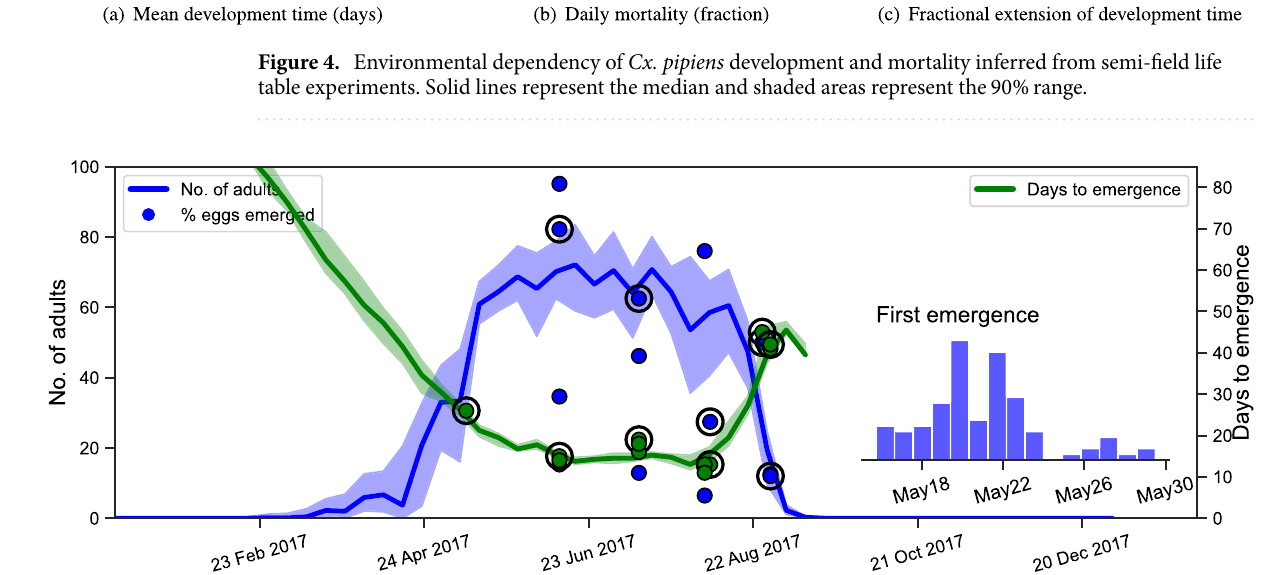
Figure 5. Annual development profile of Cx. pipiens in Petrovaradin, Serbia, in 2017. The outcome of each hypothetical semi-field experiment is plotted vertically along the y-axis at the date when the experiment is initiated. The maximum number of adults produced is given in blue, and the time it takes (from the date indicated on the x-axis) to produce half of the maximum is given in green. Solid lines represent the median and shaded areas represent the 90% range of model predictions. Outcomes of the semi-field experiments (dots) are plotted together with the model predictions. The time points marked with circles indicate the experiments used to calibrate the model. Estimated time of first adult emergence is given in the